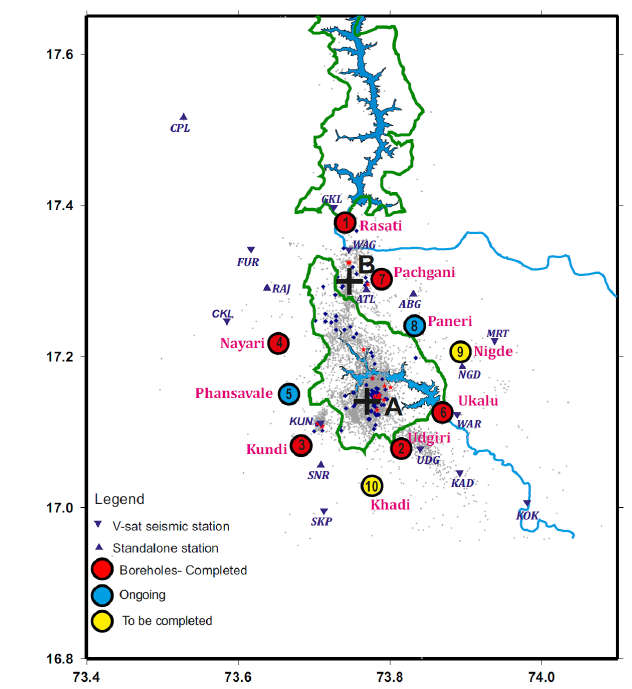
Figure 3. Locations of exploratory boreholes vis-à-vis seismic clusters. Black crosses mark proposed locations of pilot boreholes. The grey, blue and red dots represent epicenters of seismic activity over the last 9 years in increasing order of magnitude from 1.8 to 5.5. Green lines mark boundaries of reserve forest areas surround- ing the Koyna (north) and Warna (south)